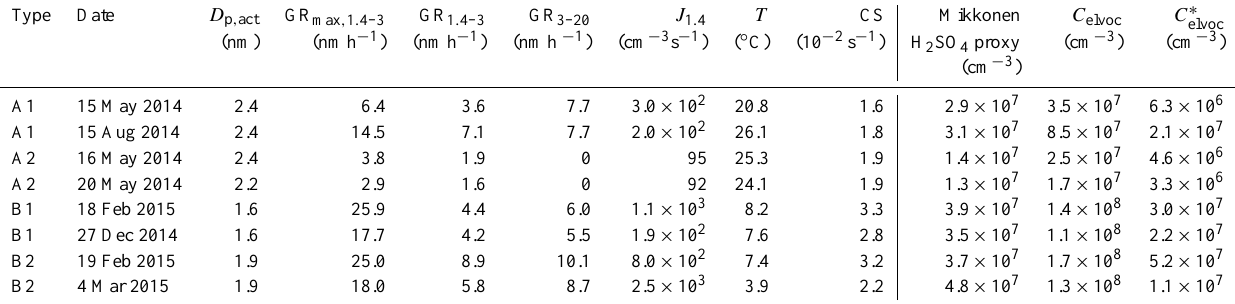
Table 1. Activation diameter ( D p , act ), maximum growth rate in 1.4–3nm (GR max , 1 . 4–3 ), overall growth rate in 1.4–3nm (GR 1 . 4–3 ),